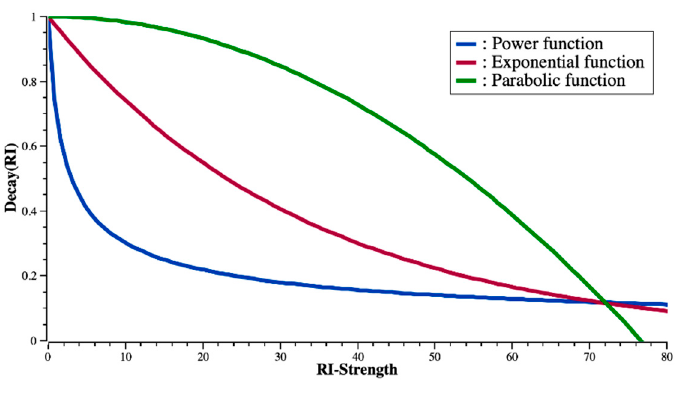
Figure 6. Preferences change over retroactive inhibition (RI)-strength for three different decay functions.